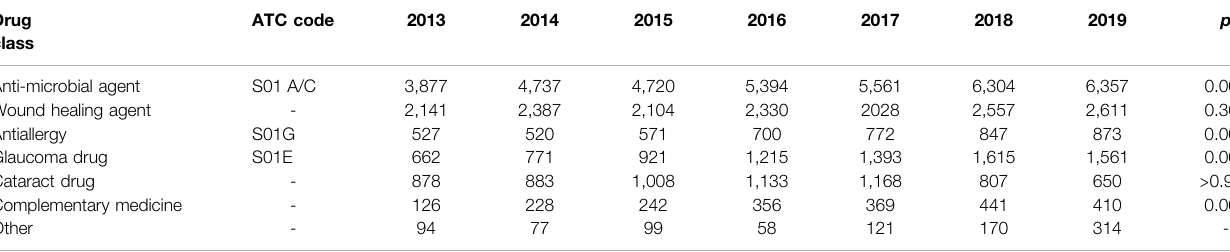
TABLE 4 | Prescription for speci fi c drug classes used to treat co-incident disease. Drug